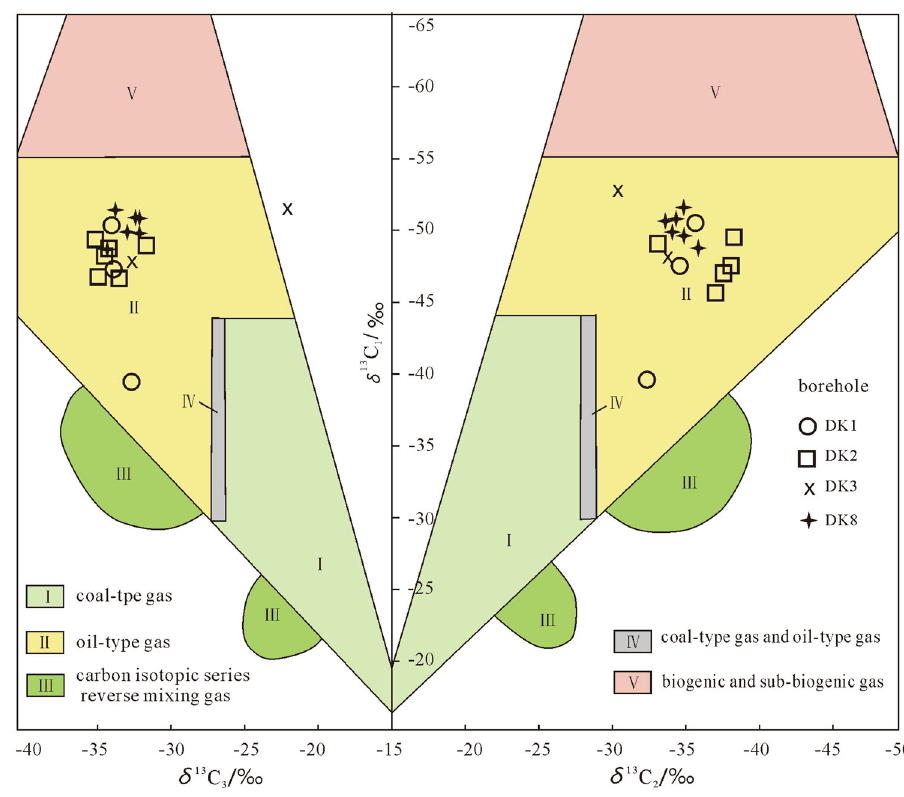
Fig. 8 Plot of d 13 C 1 vs d 13 C 2 and d 13 C 3 of hydrocarbon gases from gas hydrates in the Juhugeng Sag (after Dai 1993)